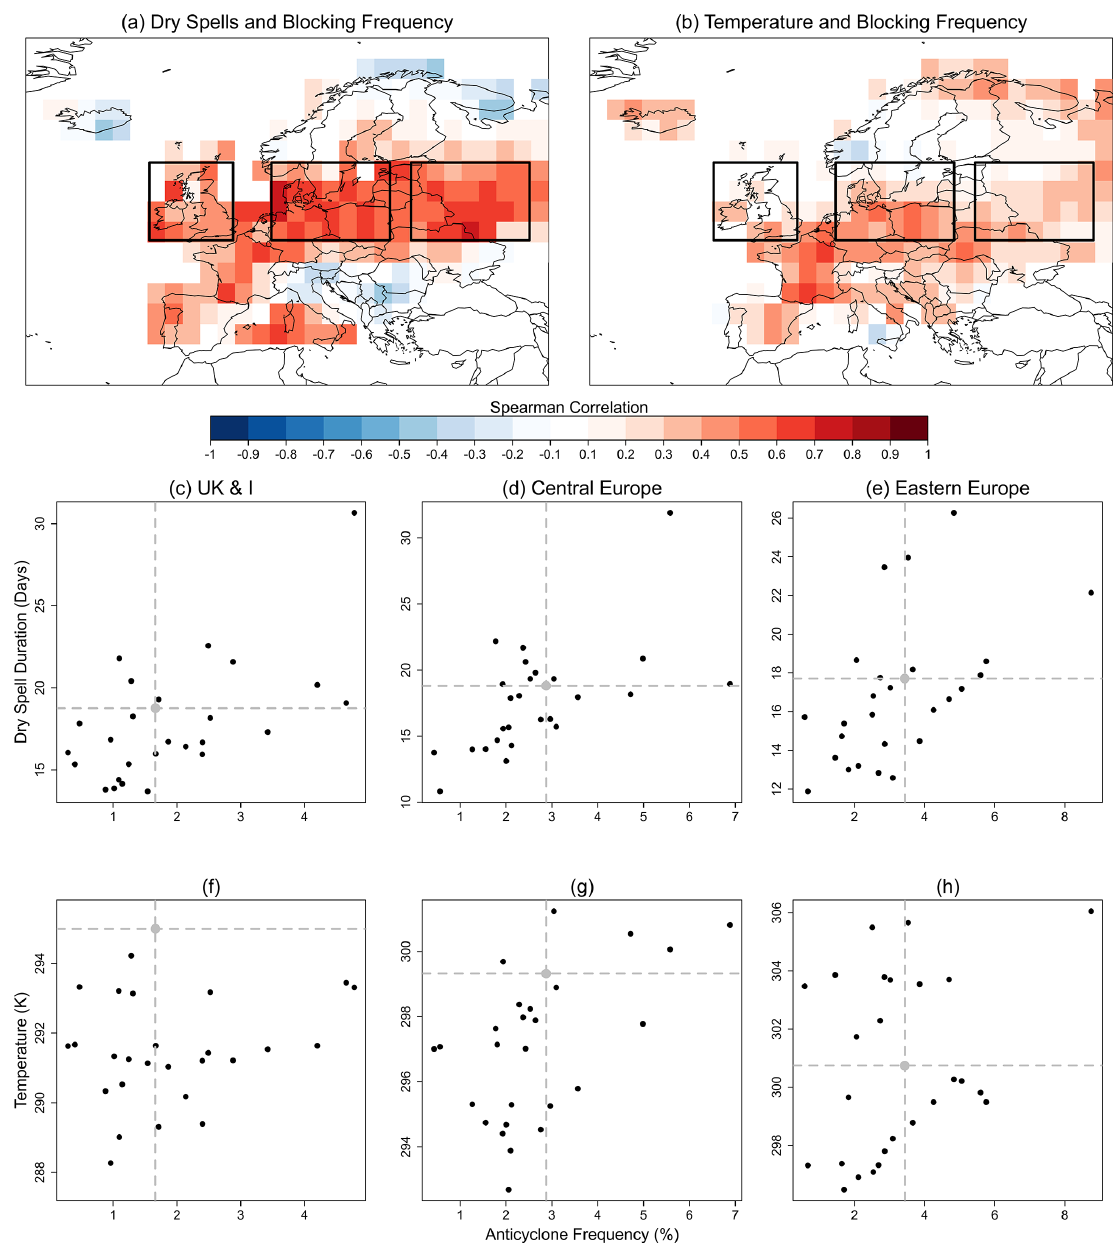
Figure A2. Relationship between frequency of blocking anticyclones, that last for at least 5d, with 5-year RLs of dry spell durations (RL DS ) and with the average maximum temperature from dry spells longer than 5d (Tx DS ). Inter-model Pearson correlation coefficients between (a) blocking frequency and RL DS and (b) blocking frequency and Tx DS . Scatter plots show inter-model relationships between AS frequency and RL DS averaged over (c) UK & Ireland, (d) central Europe, and (e) eastern Europe, as well as blocking frequency and Tx DS averaged over (f) UK & Ireland, (g) central Europe, and (h) eastern Europe. Each point represents a model, while the grey dot in each panel represents the metrics obtained from EOBS (RL DS , Tx DS ) and ERA5 (AS frequency). The three regions used to demonstrate these relationships are indicated by the black boxes in (a)